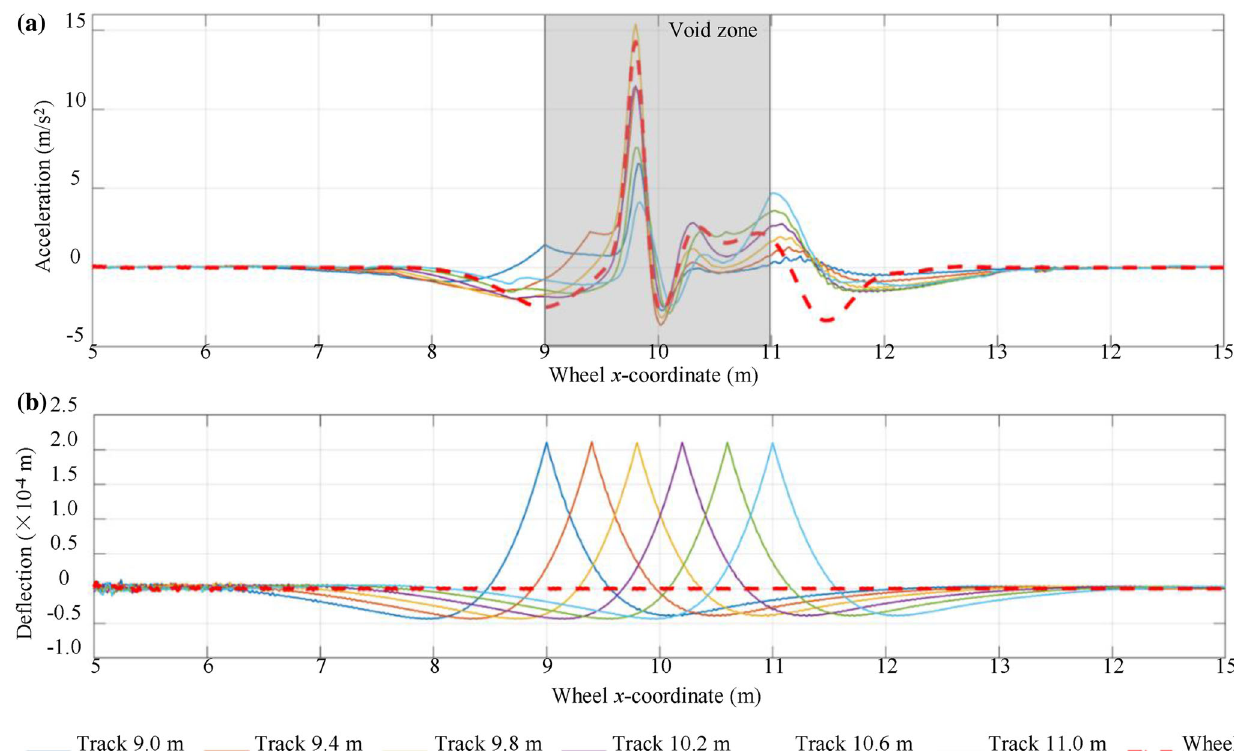
Fig. 10 Simulated rail and wheel accelerations in the voided zone ( a ) and the zone without voids ( b